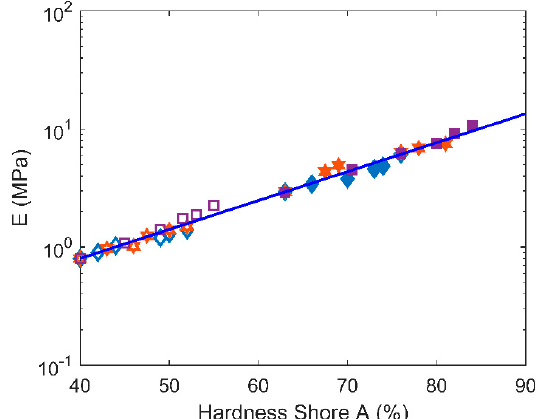
Figure 9. Young’s modulus (E) versus hardness shore A for all samples (filled, unfilled) and temperatures.